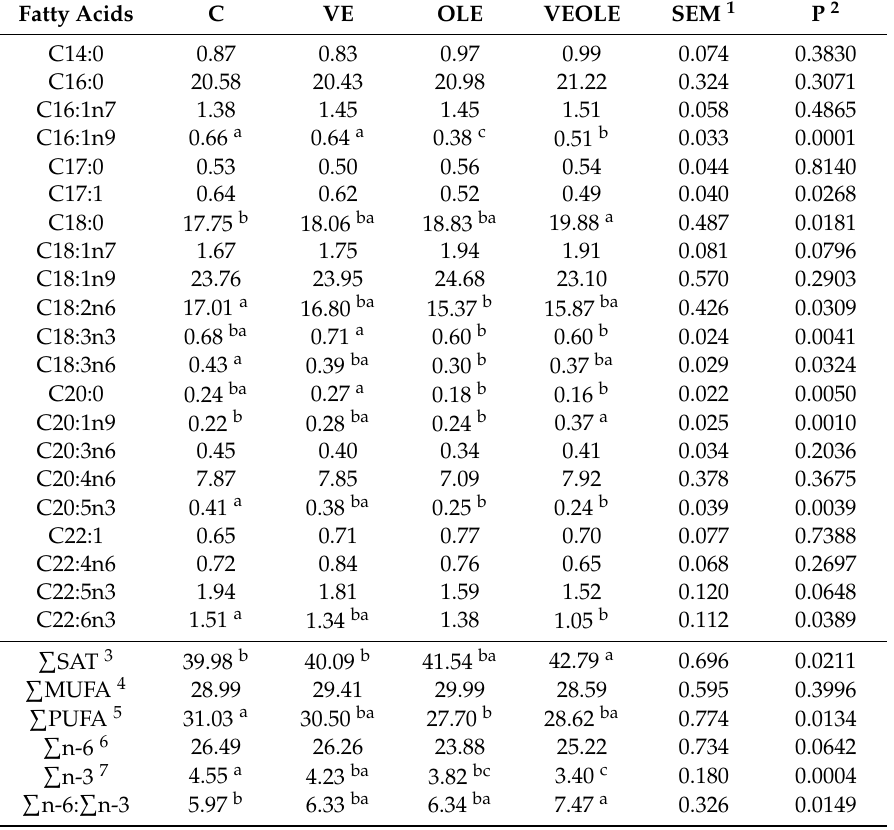
Table 3. E ff ect of dietary oleuropein (OLE), vitamin E and selenium (VE), or their combination (VEOLE) on the total fatty acid profile (g / 100 g total fatty acids) of plasma samples from pigs fed the experimental diets.